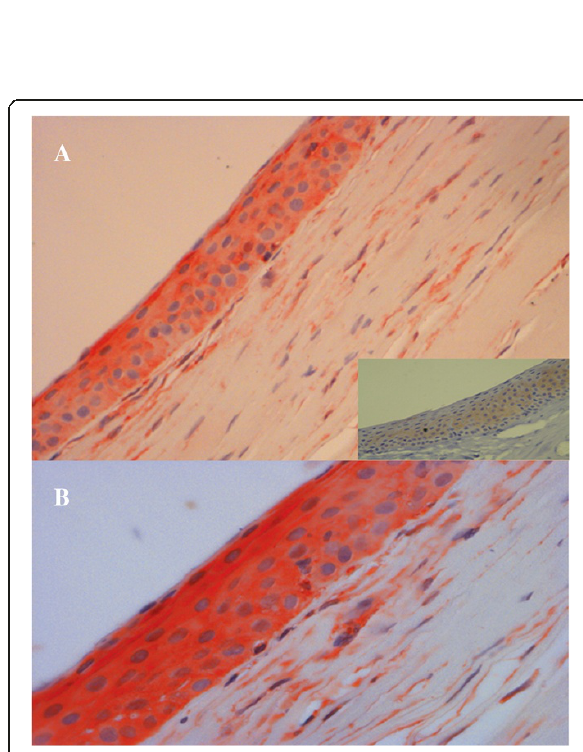
Figure 5 Immunohistochemical profile of corneal tissue with HSK. In active keratitis, strong TCTP staining was observed throughout all layers of the corneal epithelium, as well as in stromal cells (A-B), whereas in quiescent disease little or no expression was present (A, inset) [A, O.M 10x; B, O.M. 20x; inset, O.M.